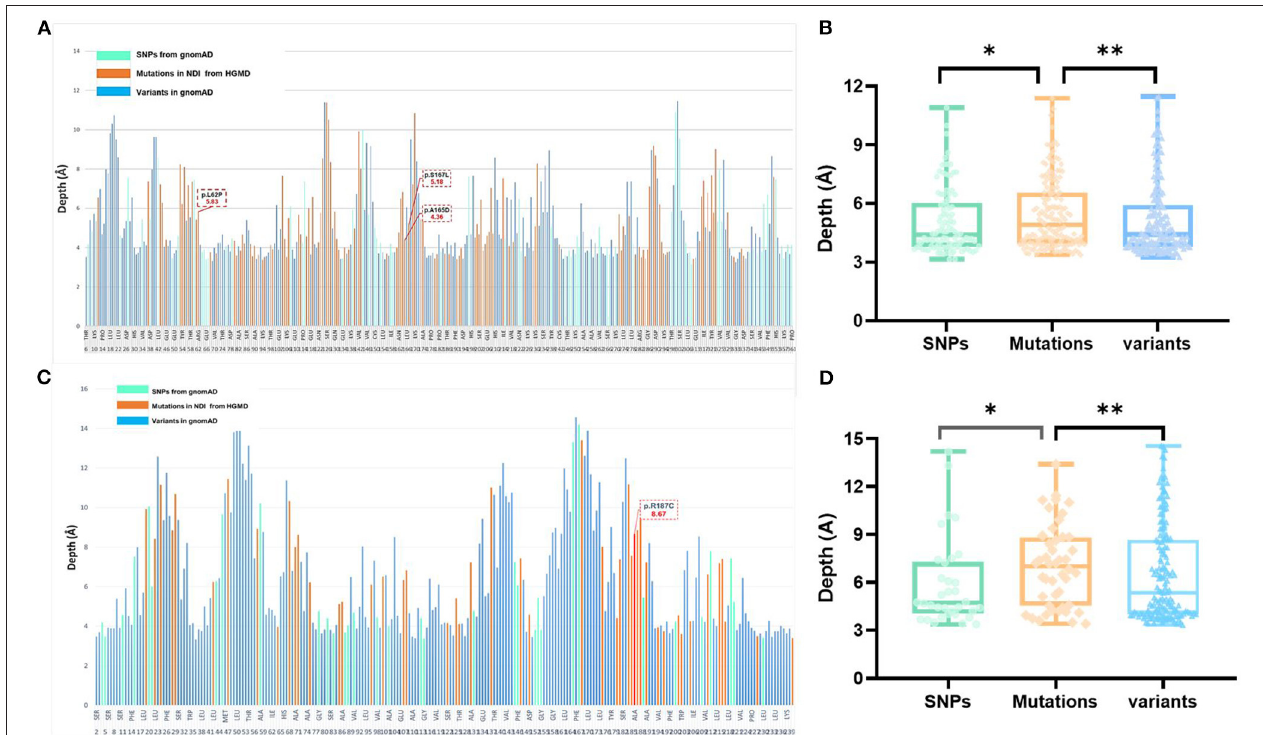
FIGURE 2 | Analysis of variants and residue depth computation in AVPR2 and AQP2. (A) A 2D plot of residue-wise depth of AVPR2 (PDB 6U1N) with bars indicating the diagnostic mutations by HGMD (orange), population variants/SNPs by gnomAD (turquoise), and all the other residues (blue). (B) Boxplot of the residue depth (9) comparing the diagnostic mutations (orange), population variants/SNPs (turquoise), and all the other residues (blue) in AVPR2. * p = 2e − 8 , ** p = 2e − 5 (Wilcoxon–Mann–Whitney test). (C) A 2D plot of residue-wise depth of AQP2 (PDB 4NEF) with bars indicating the diagnostic mutations by HGMD (orange), population variants/SNPs by gnomAD (turquoise), and all the other residues (blue). (D) Boxplot of the residue depth comparing the diagnostic mutations (orange), population variants/SNPs (turquoise), and all the other residues (blue) in AQP2. * p = 2e − 7 , ** p = 2e − 5 (Wilcoxon–Mann–Whitney